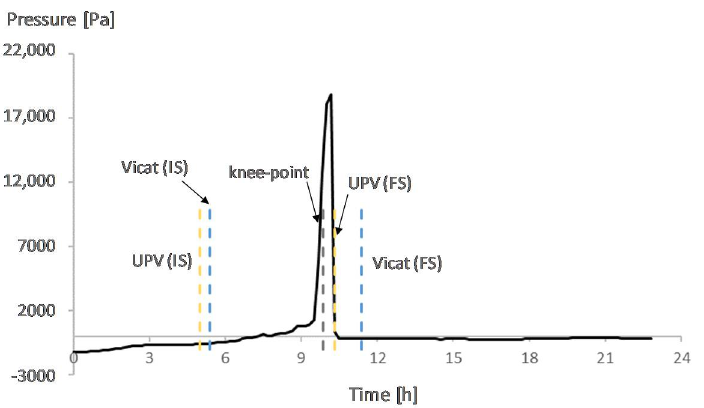
Figure 7. Capillary pressure, setting times, and transition point of REF0.3. With IS referring to initial setting and FS referring to final setting.